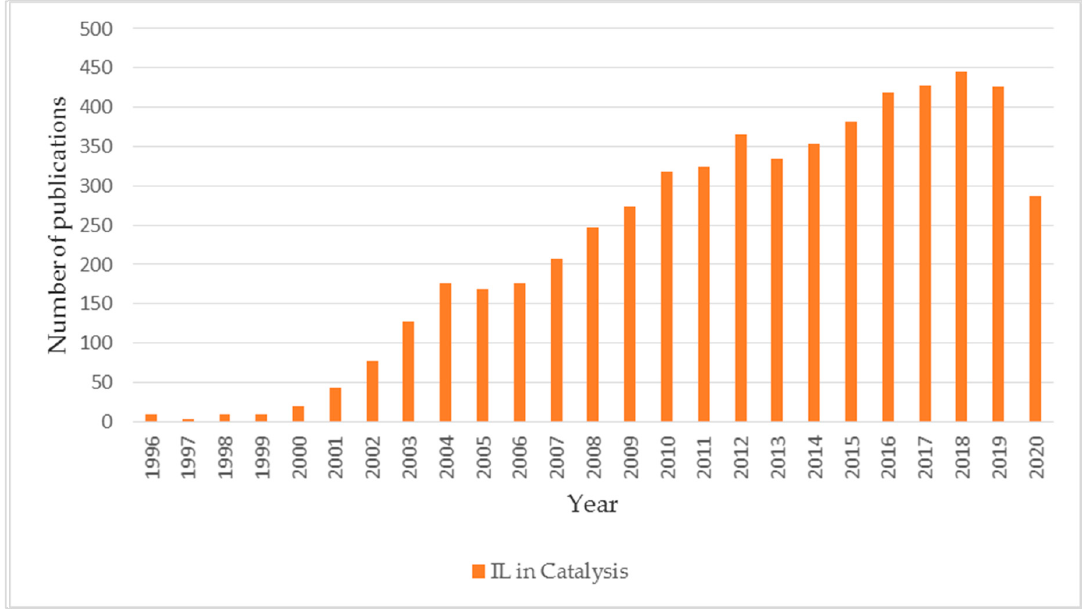
Figure 3. Number of publications on ionic liquids in catalysis in the period 1996–2020.